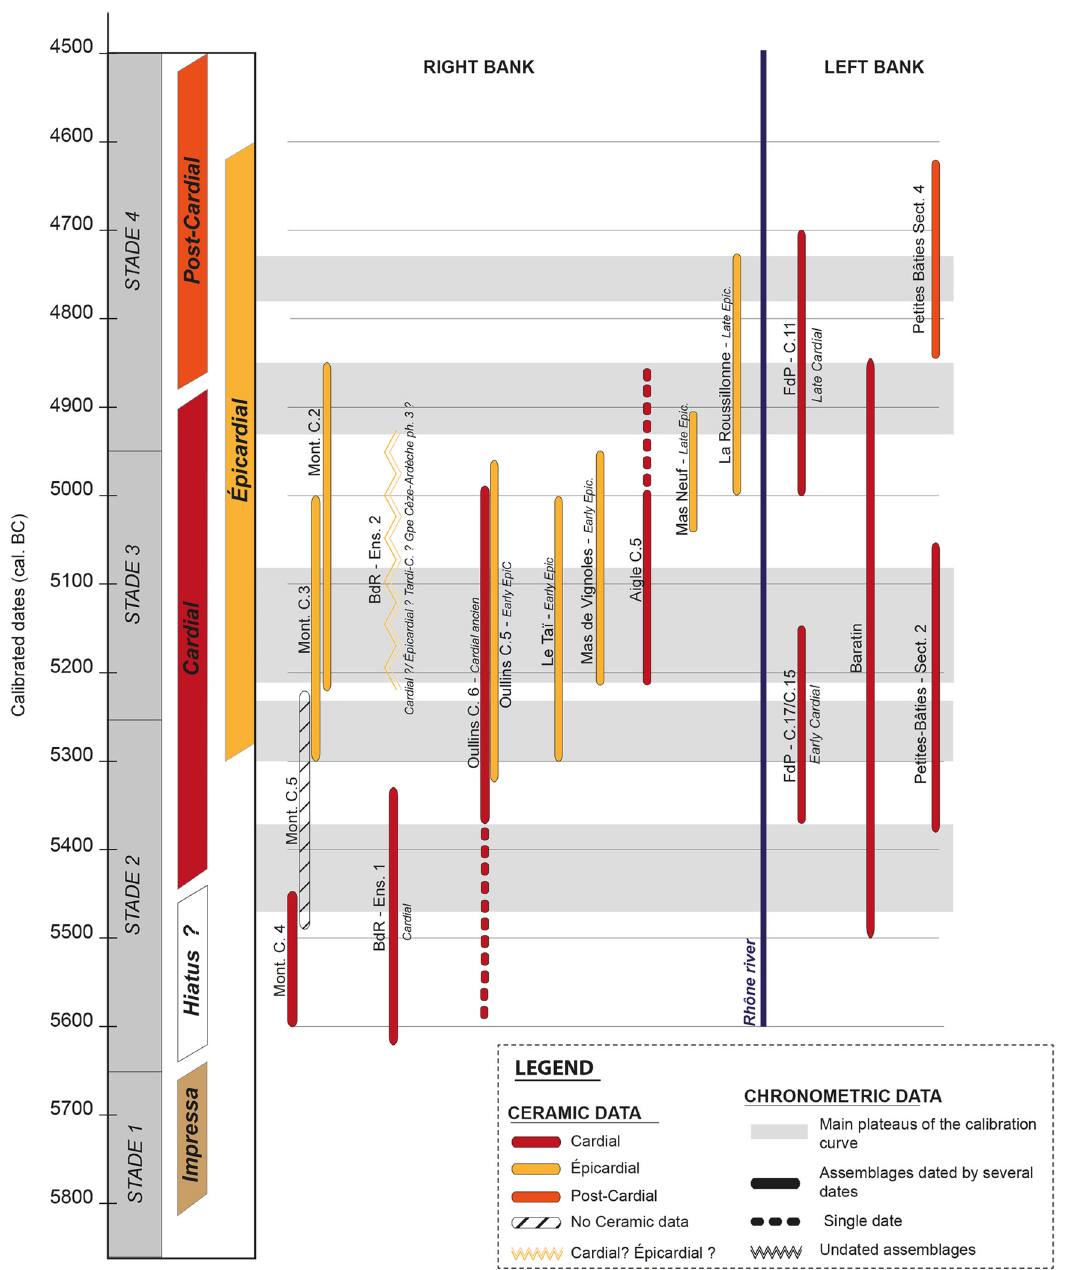
Figure 2: Chrono - cultural articulation of the lithic assemblages of the corpus in conjunction with pottery and radiocarbon data ( abbreviations: Mont.: Montclus, BdR: Baume de Ronze, FdP: Font - des - Pigeons, ÉpiC.: Épicardial ) . The grey bands illustrate the main plateaux of the calibration